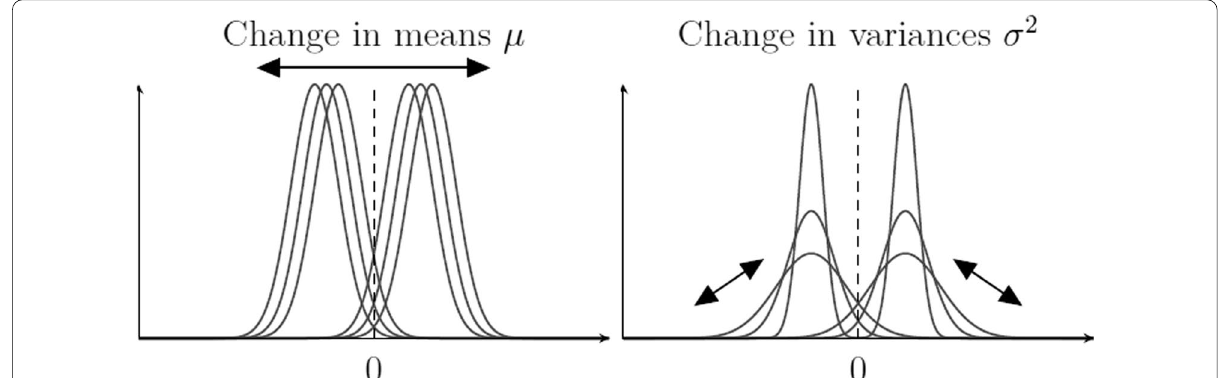
Fig. 5 Illustration of how the latent strength distributions can change across sequence positions under different SDT models. The dashed lines indicate the origin of the latent strength